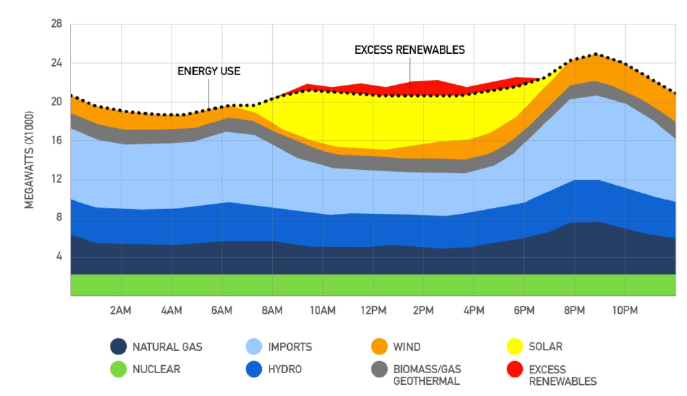
Figure 1. Generic daily power mix using programmable and renewable energy systems